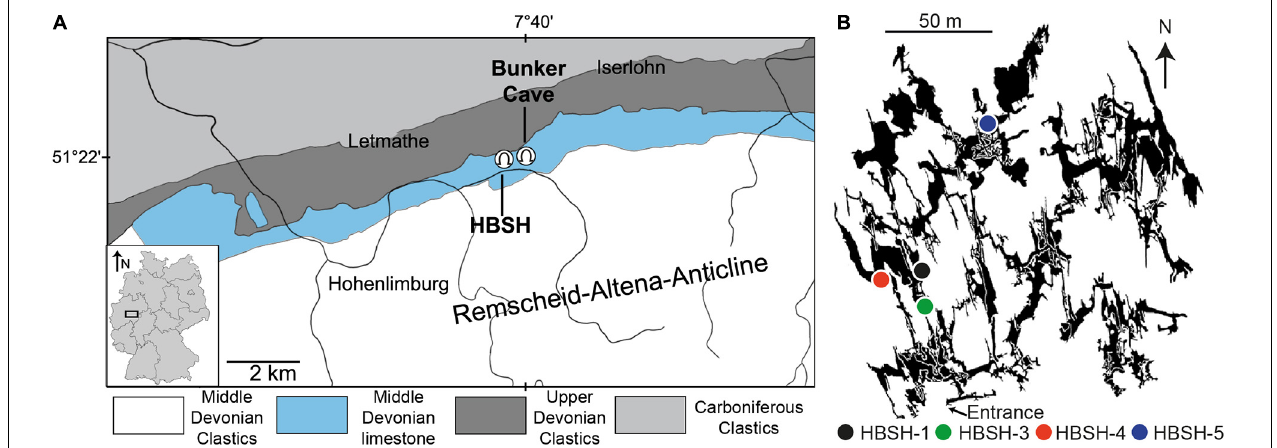
FIGURE 1 | (A) Geological map of the cave area with the locations of Hüttenbläserschachthöhle (HBSH) and Bunker Cave. Modified after Riechelmann et al. (2011). (B) Cave map of HBSH with the location of the stalagmite sampling sites. Modified after Grebe (1994).